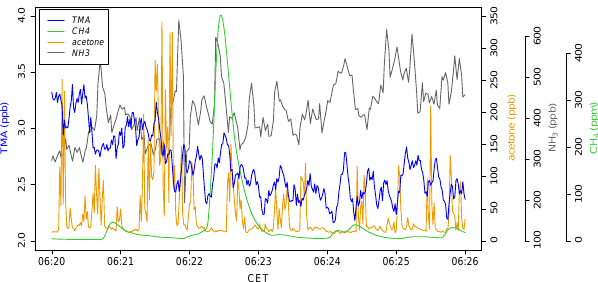
Figure 1. High-resolution time series of acetone, NH 3 , and TMA (8s moving average) during measurements in front of the mouth of a ruminating cow at the outdoor yard on 28 July 2011; the average TMA : NH 3 ratio for this period was